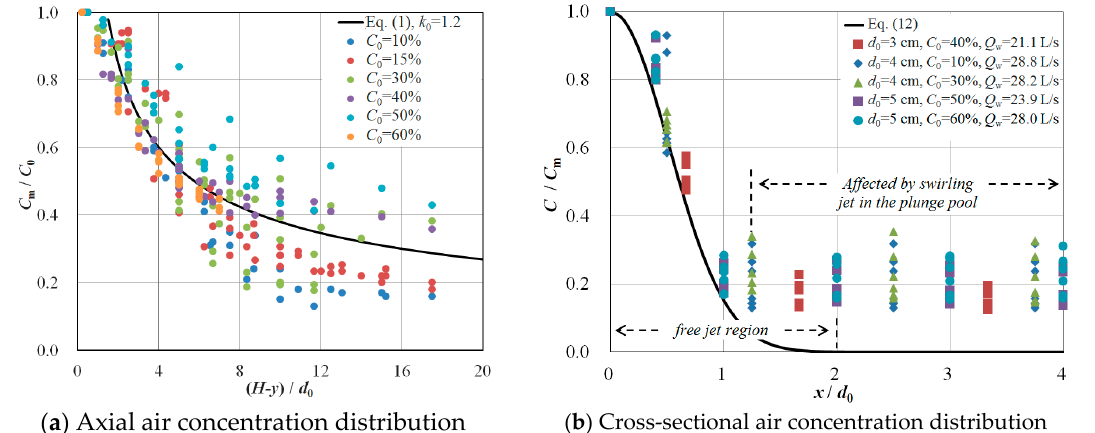
Figure 5. Air concentration distribution in the free jet region.